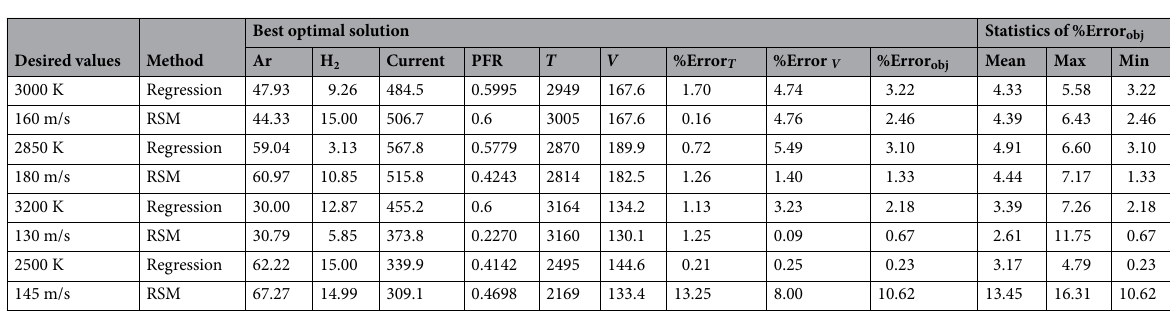
Table 6. Optimal input parameters for the desirable MPCs with weighting coefficient, w = 0.5